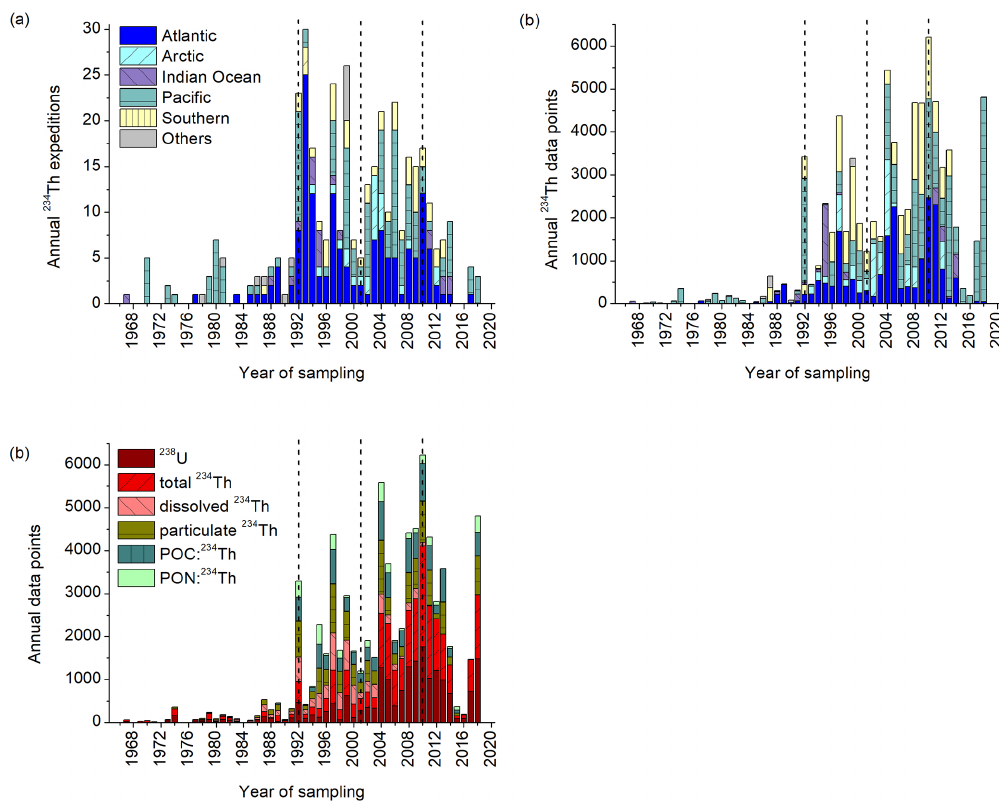
Figure 2. (a) Time distribution of annual field surveys with 234 Th measurements since the first reported sampling in 1967 separated by ocean. (b) Equivalent figure for 234 Th data points. Note that oceans are distinguished as (i) Atlantic, (ii) Arctic, (iii) Indian, (iv) Pacific, and (v) Southern, with an additional category for (vi) others, which includes rivers, lakes, and bays. (c) Histogram of 234 Th data points sampled since 1967 separated by data type as follows: (i) 238 U, (ii) total 234 Th, (iii) dissolved 234 Th, (iv) particulate 234 Th, (v) POC : 234 Th ratios, and (vi) PON : 234 Th ratios. Dotted lines indicate tipping points in the 234 Th